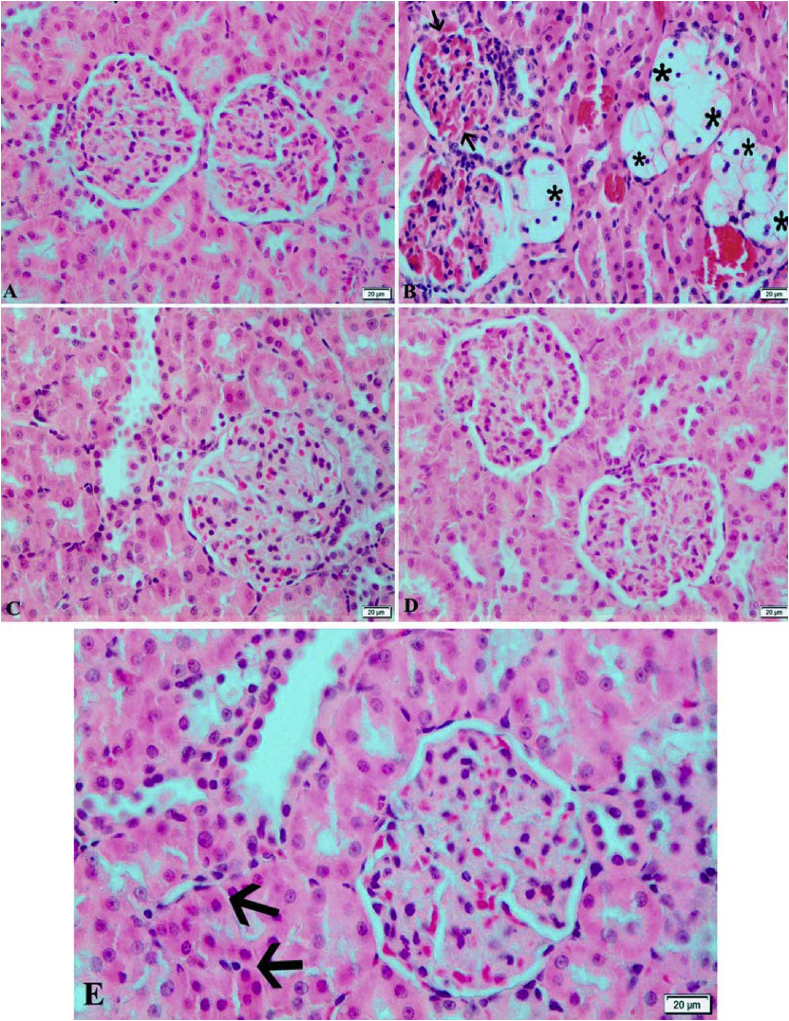
Hematoxylin and eosin-stained sections of kidney. A) Control group: Normal histological appearance. B) Diabetic group: Showing adhesions (arrows) between the glomerulus and Bowman capsule, and severe degeneration (stars) of tubular epithelium. C) Diabetic + L. nobilis treated group: Almost normal histological appearance of tubular epithelium and glomerulus. D)L. nobilis group: Normal histological appearance of tubular epithelium and glomerulus. E) Diabetic + Acarbose treated group: showing degenerative and necrotic changes (arrows) in some tubular epithelium. Bar = 20 μm.